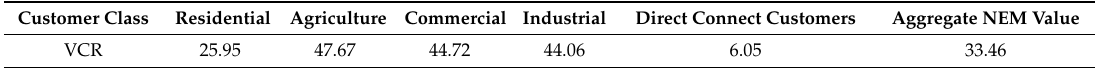
Table 6. NEM level VCR results